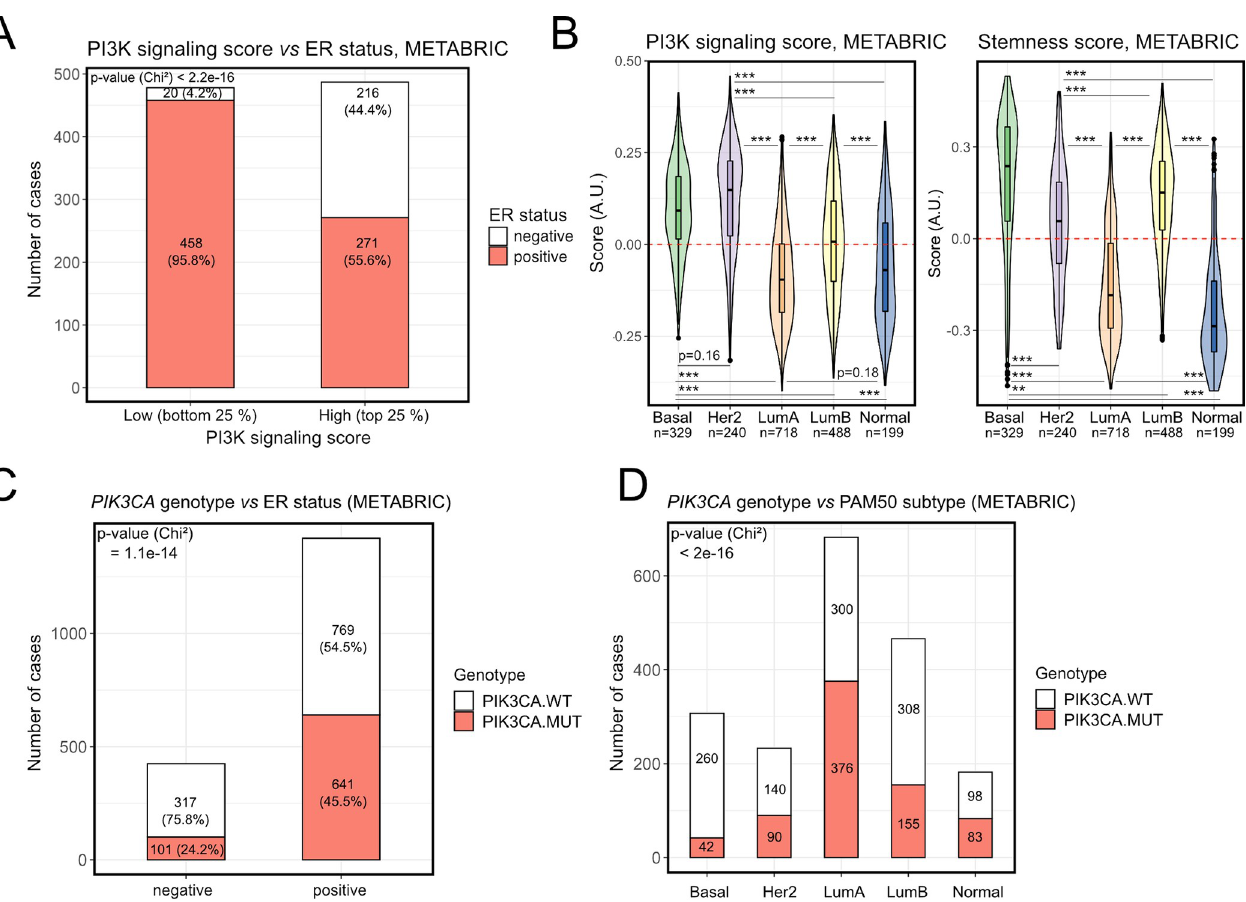
Fig 3. High PI3K signaling and stemness scores, but not PIK3CA mutations, are enriched in aggressive breast cancer subtypes. (A) PI3K signaling score distribution in METABRIC breast tumors stratified according to ER status. (B) PI3K signaling and stemness score distributions across METABRIC breast cancers stratified according to PAM50 subtype; �� p � 0.01, ��� p � 0.001 according to Tukey’s Honest Significant Differences method. (C) and (D) The distribution of PIK3CA wild-type (PIK3CA.WT) and mutant (PIK3CA.MUT) samples in METABRIC breast cancers, stratified according to ER status (C) or PAM50 subtype